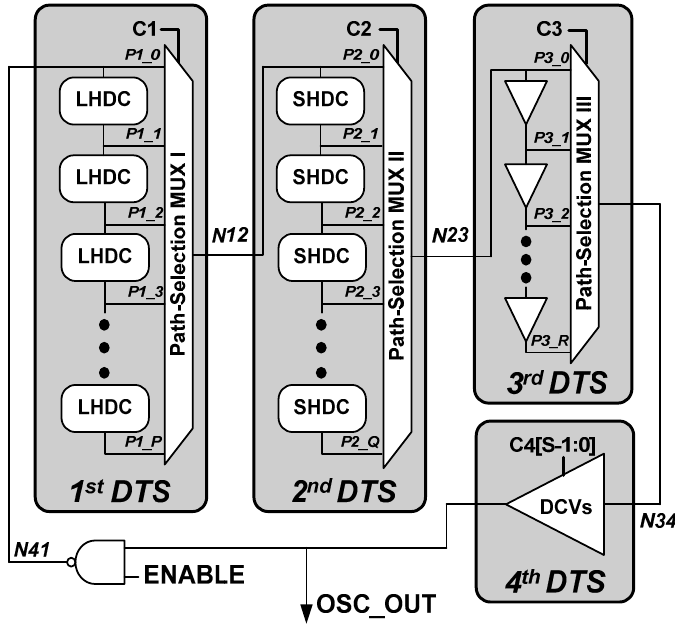
Figure 2. The architecture of the proposed digitally controlled oscillator (DCO).